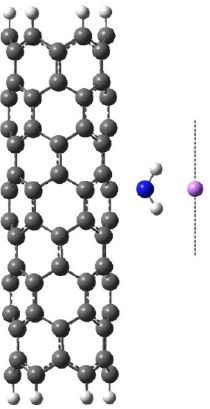
Figure 4. A scan of an arbitrary site on the surface modified carbon nanotube (6,0) that contain a Li atom (a pink color ball of a larger size); the dotted line indicates the route of Li atom movement in relation to an amino group functionally modified nanotube.